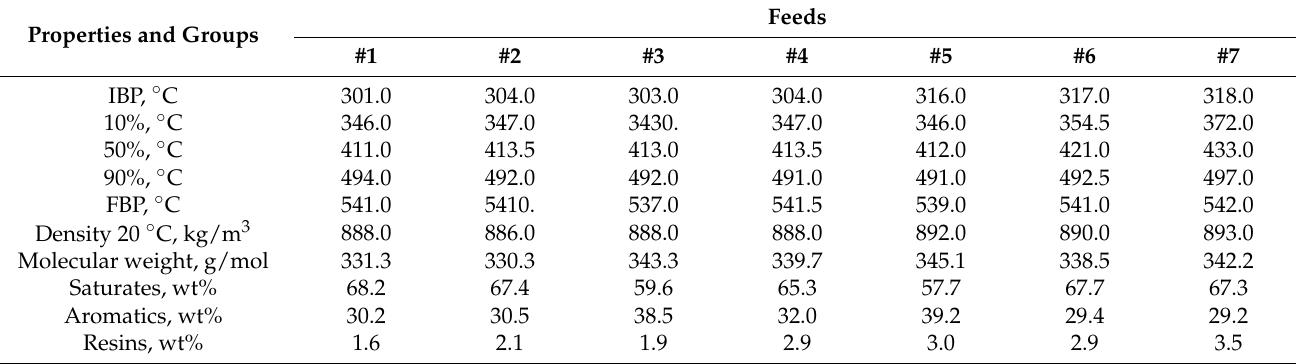
Table 1. Results of laboratory study of catalytic cracking